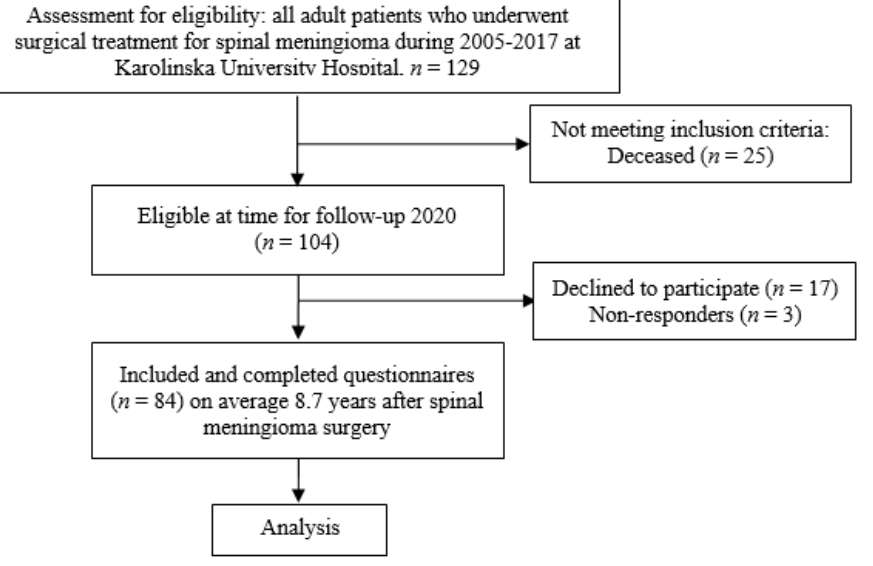
Figure 1. Flowchart of the patient inclusion process.